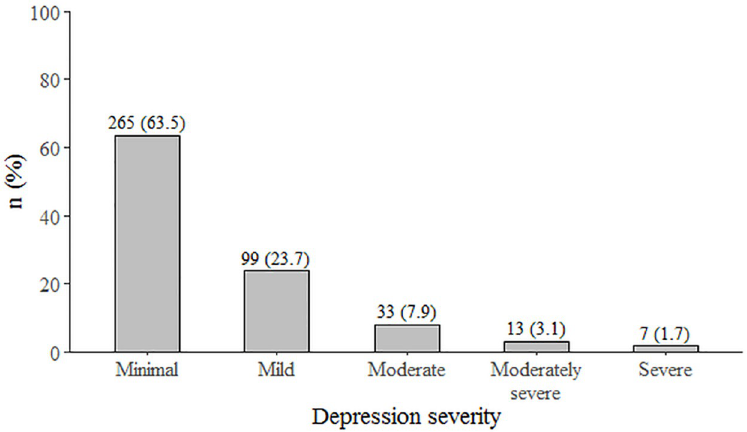
Fig 1. Distribution of depression severity in patients with chronic disease in the UAE (N = 417).